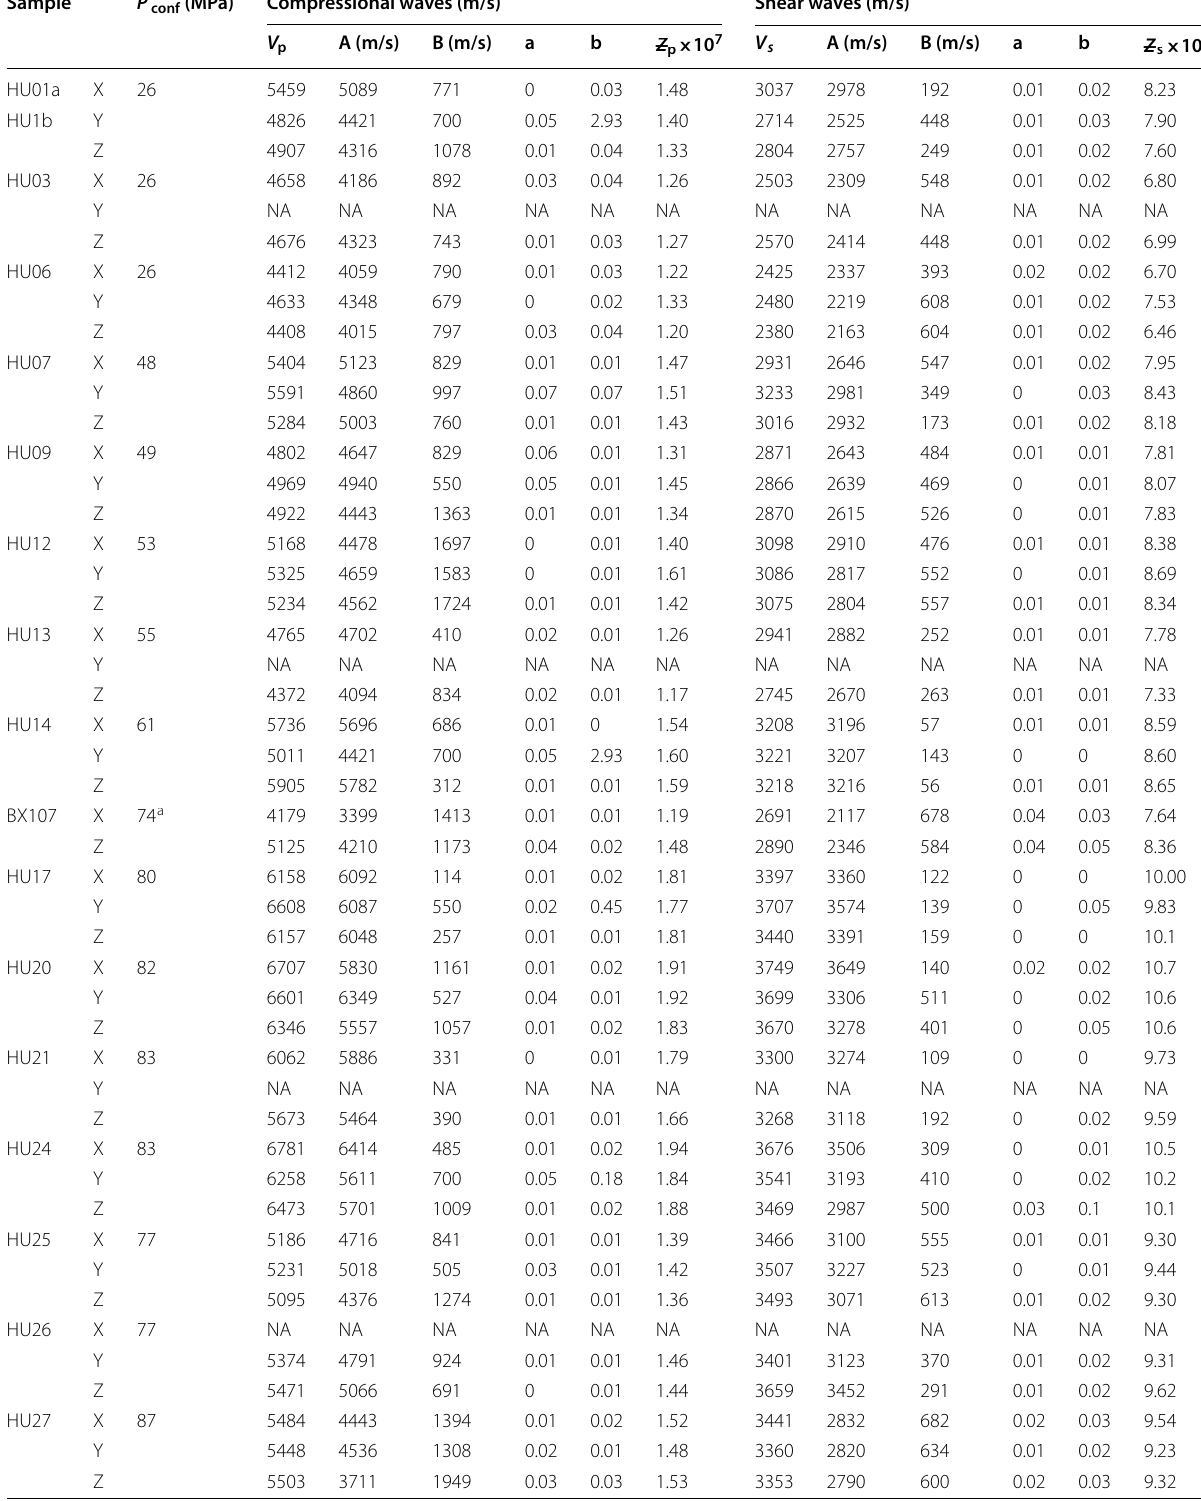
Table 4 Velocities (m/s) at borehole